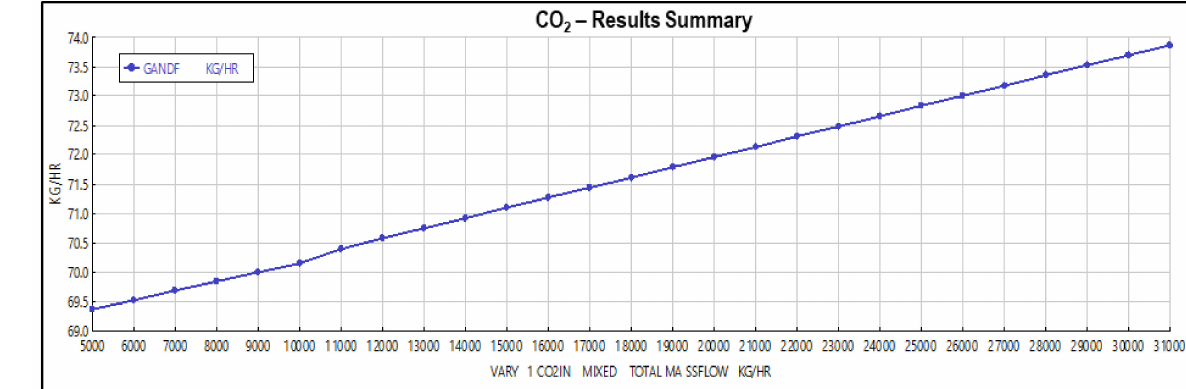
Figure 5. Effect of Sc-CO 2 flow rate on glucose and fructose recovery from date pulp.